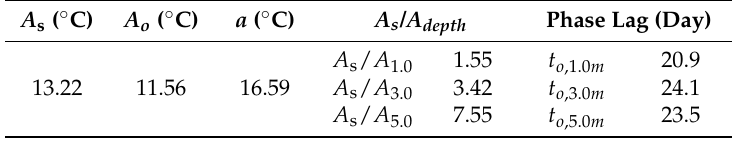
Table 4. Coefficients for estimating the ground temperature in Tokyo, Japan.